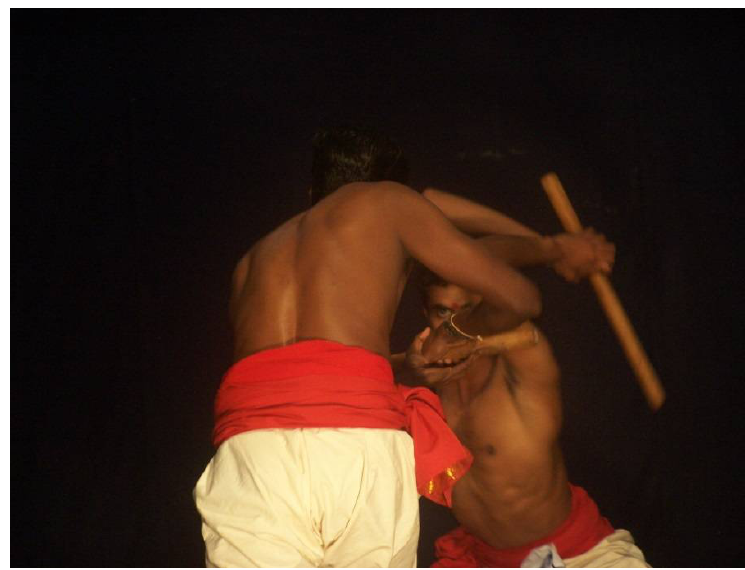
Figure A3. Ka ḷ aripaya ṯṯ u performance in Calicut (author).